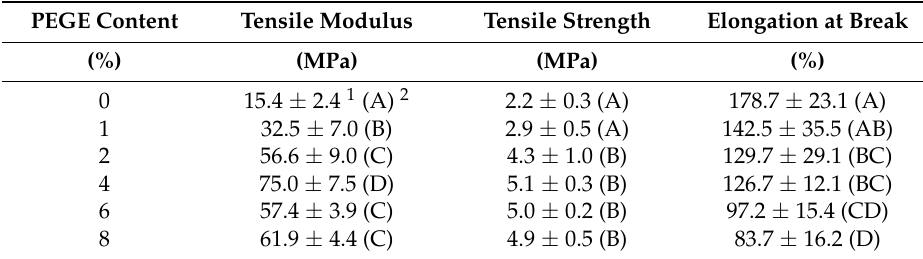
Table 4. A comparison of tensile modulus, strength and elongation at break of the SPI/SDBS/PEGE films by adding various amounts of PEGE.